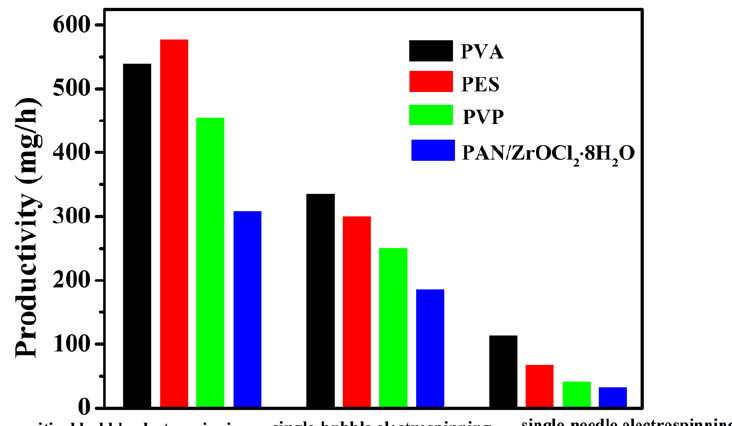
Figure 13. The nanofiber productivity of single-needle / bubble electrospinning and critical bubble electrospinning.